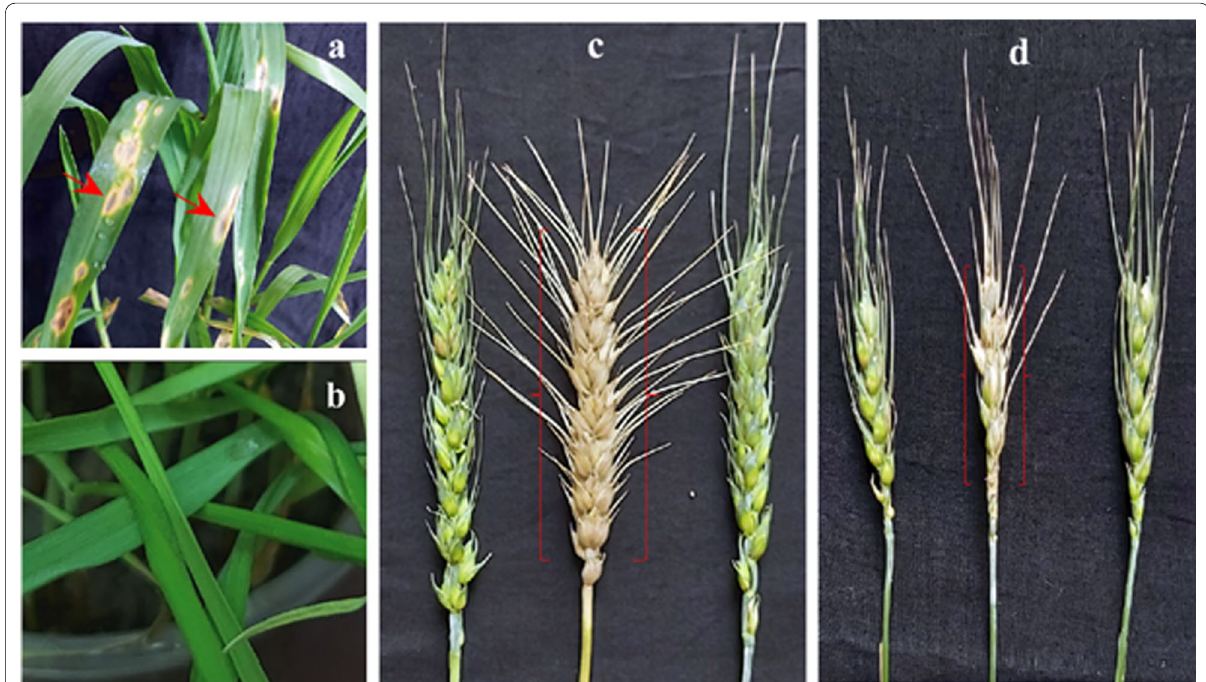
Fig. 3 Head and leaf blast symptoms developed in wheat leaves and spikes after artificial inoculation of plants with conidia of MoT strains BTJP4‑5 and BTMaU(10b). a Typical eye‑shaped lesions with gray center (arrows) on the leaves of wheat seedling. b Mock‑inoculated control wheat leaves showed no blast disease symptoms. c , d The middle spikes in c and d were completely bleached when inoculated with MoT strains, BTJP4‑5 and BTMaU(10b), respectively, whereas mock‑inoculated control (the right and left spikes) were free from blast